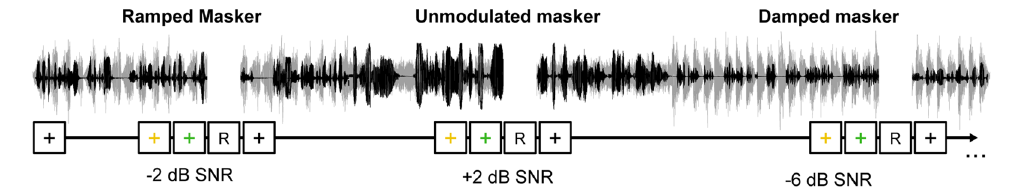
Figure 3. Stimulus design for Experiment 2. Participants listened to a spoken story (black) masked with 12-talker babble noise (grey). The amplitude envelope (damped, ramped, unmodulated) and SNR (− 6, − 2, + 2, Clear) pseudo-randomly varied every 16-s. A fixation cross was displayed on the computer screen throughout the story and changed colors to communicate which parts of the story participants would need to report. The fixation cross turned yellow 2-s prior to the beginning of a test phrase/sentence, cueing the participant to prepare for intelligibility testing, and turned green at the start of the test phrase/sentence to indicate which phrase/sentence they should report back. The story paused with the offset of the test phrase/sentence, at which point participants would report back the phrase/sentence. The story resumed once a response was